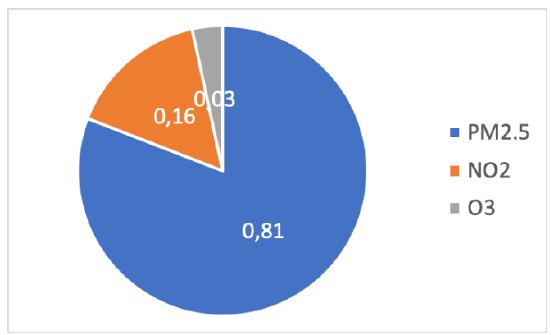
Figure 34. Repartition of air pollution in terms of premature deaths due to PM 2.5 , NO 2 , and O 3 . for EU-28 in 2015.